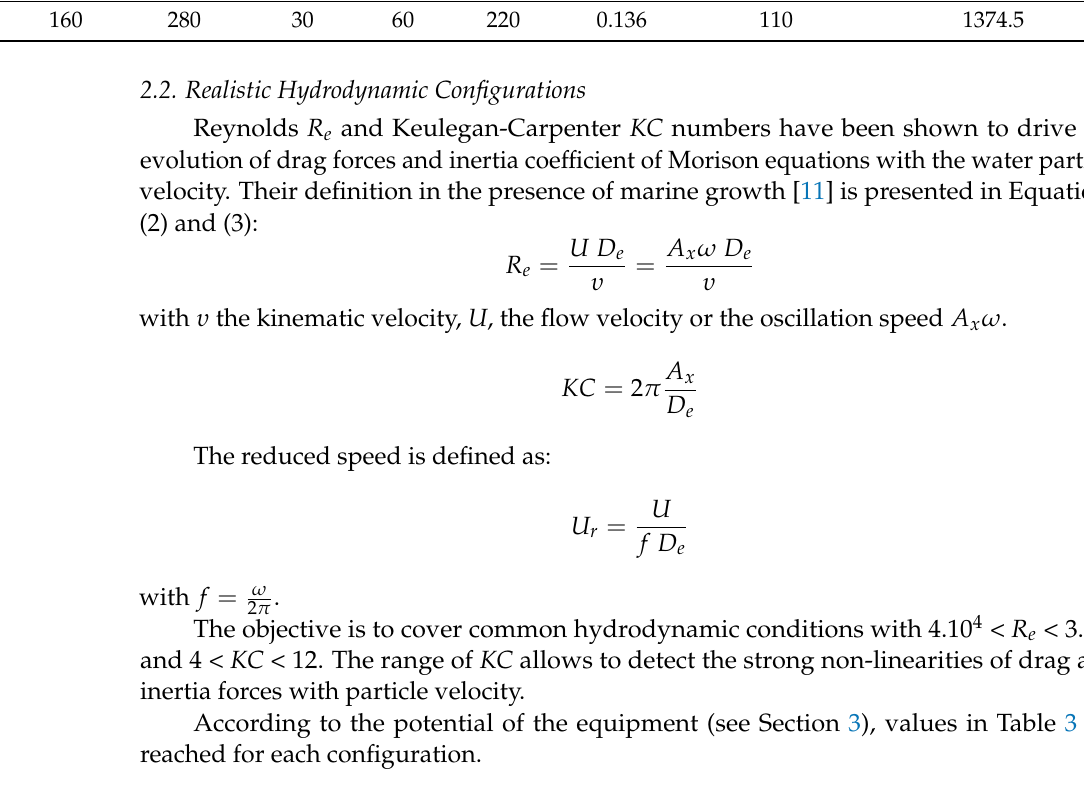
Table 3. Synthesis of the normalized numbers covered for all